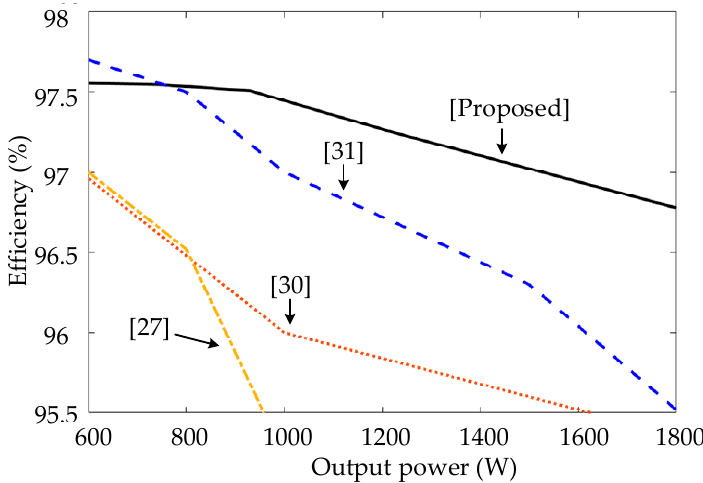
Figure 16. Recorded efficiency of different topologies.